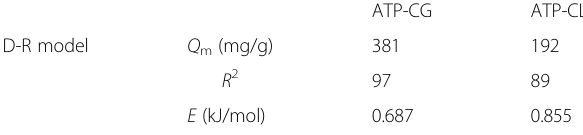
Table 1 Parameters of adsorption isotherms for microspheres